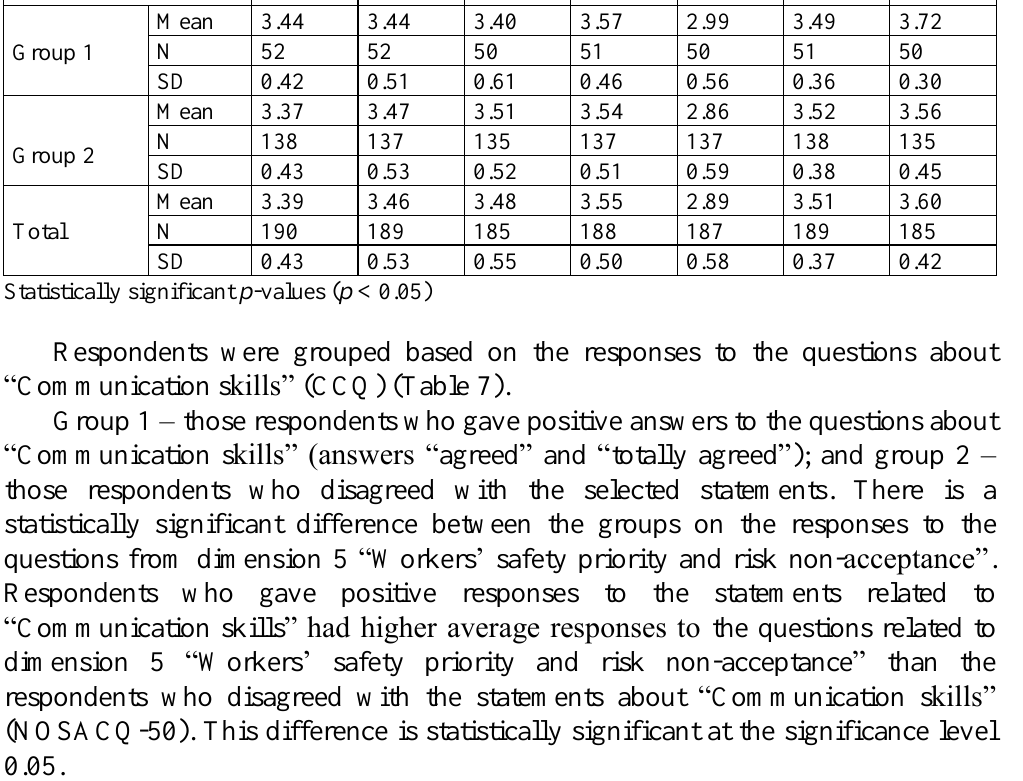
Table 7. Relationships between Factors of Safety Climate and Scale of Professional Competence “Communication Skills” among Caregivers Scale 4